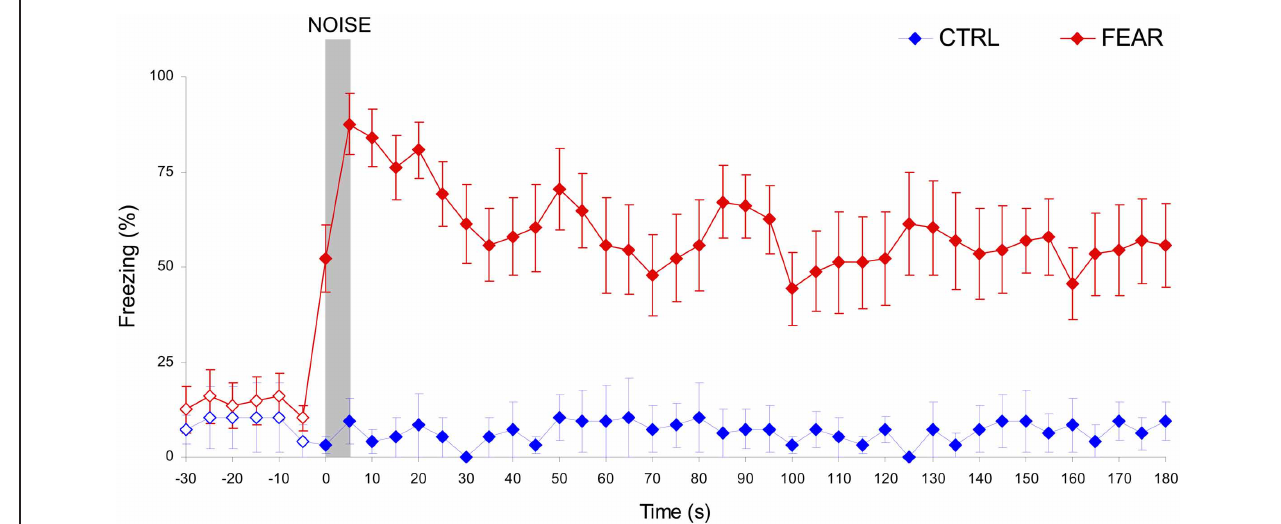
FIGURE 3 | Long-lasting freezing behavior following the presentation of the auditory distracter in the FEAR, but not CTRL rats. Average percent freezing behavior ( ± SEM) in the fear conditioning context during freezing behavior testing and re-training sessions, before, during, and after the presentation of the noise (in extinction, no shock). Unlike CTRL rats, FEAR